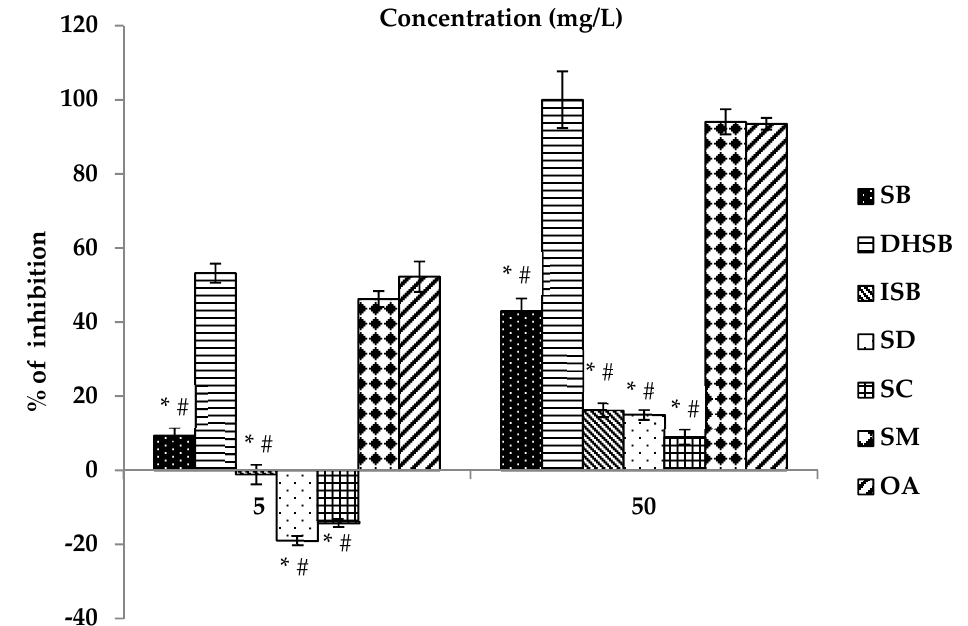
Figure 3. Anti-elastase activity of silymarin and flavonolignans. Silybin (SB), dehydrosilybin (DHSB), isosilybin (ISB), silydianin (SD), silychristin (SC), silymarin (SM), oleanolic acid (OA). OA is a standard inhibitor of elastase. Data are expressed as mean ± SEM from four independent experiments carried out in triplicate. # Significantly different from OA as the standard inhibitor at p = 0.05; * significantly different from SM at p = 0.05.